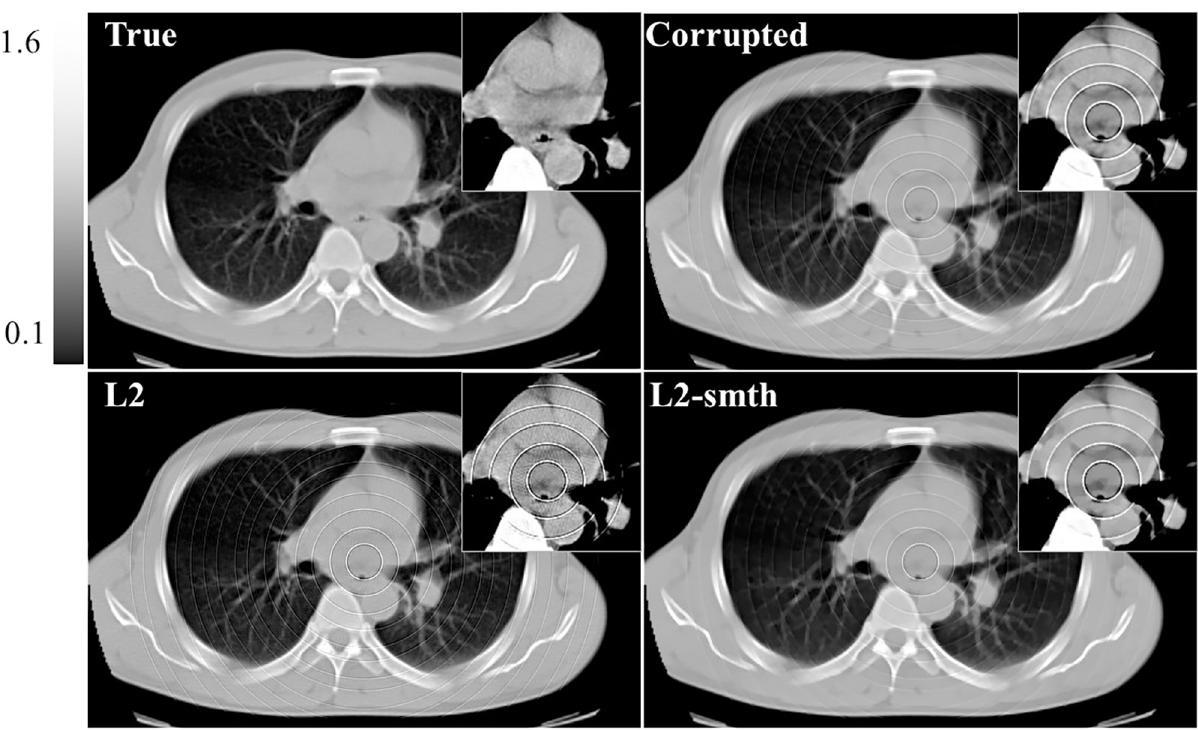
Fig 2. Reconstructed images using ℓ 2 and ℓ 2 -smth algorithms for the first study case. All reconstructed images in figures hereafter are displayed with the same grayscale for consistency.